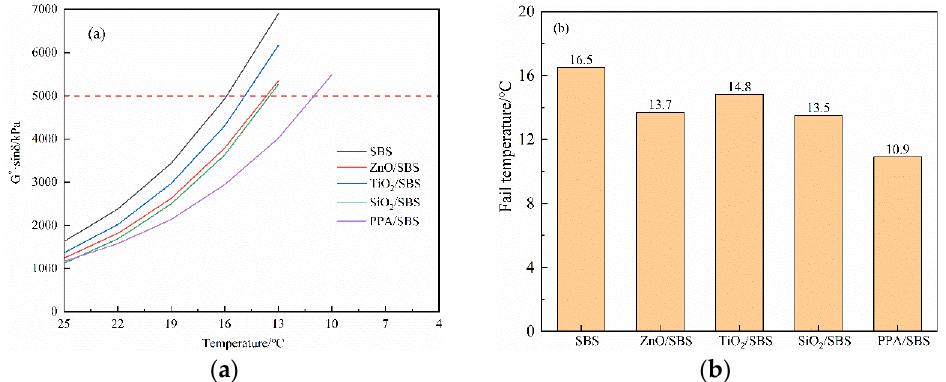
Figure 4. Fatigue factor ( a ) and failure temperature ( b ) of different SBS composite modified asphalts after PAV aging.